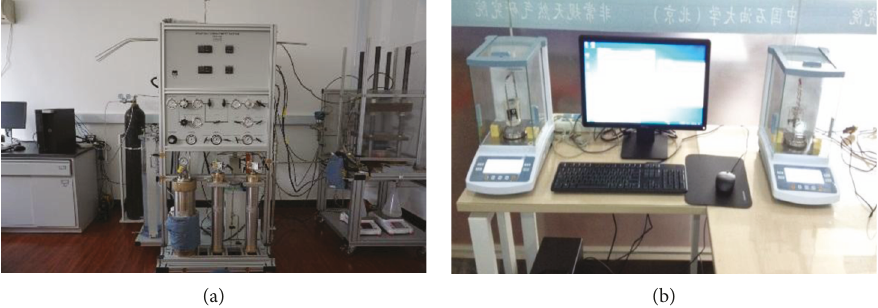
Figure 5: Experimental apparatus: (a) modi fi ed conductivity apparatus and (b) spontaneous imbibition